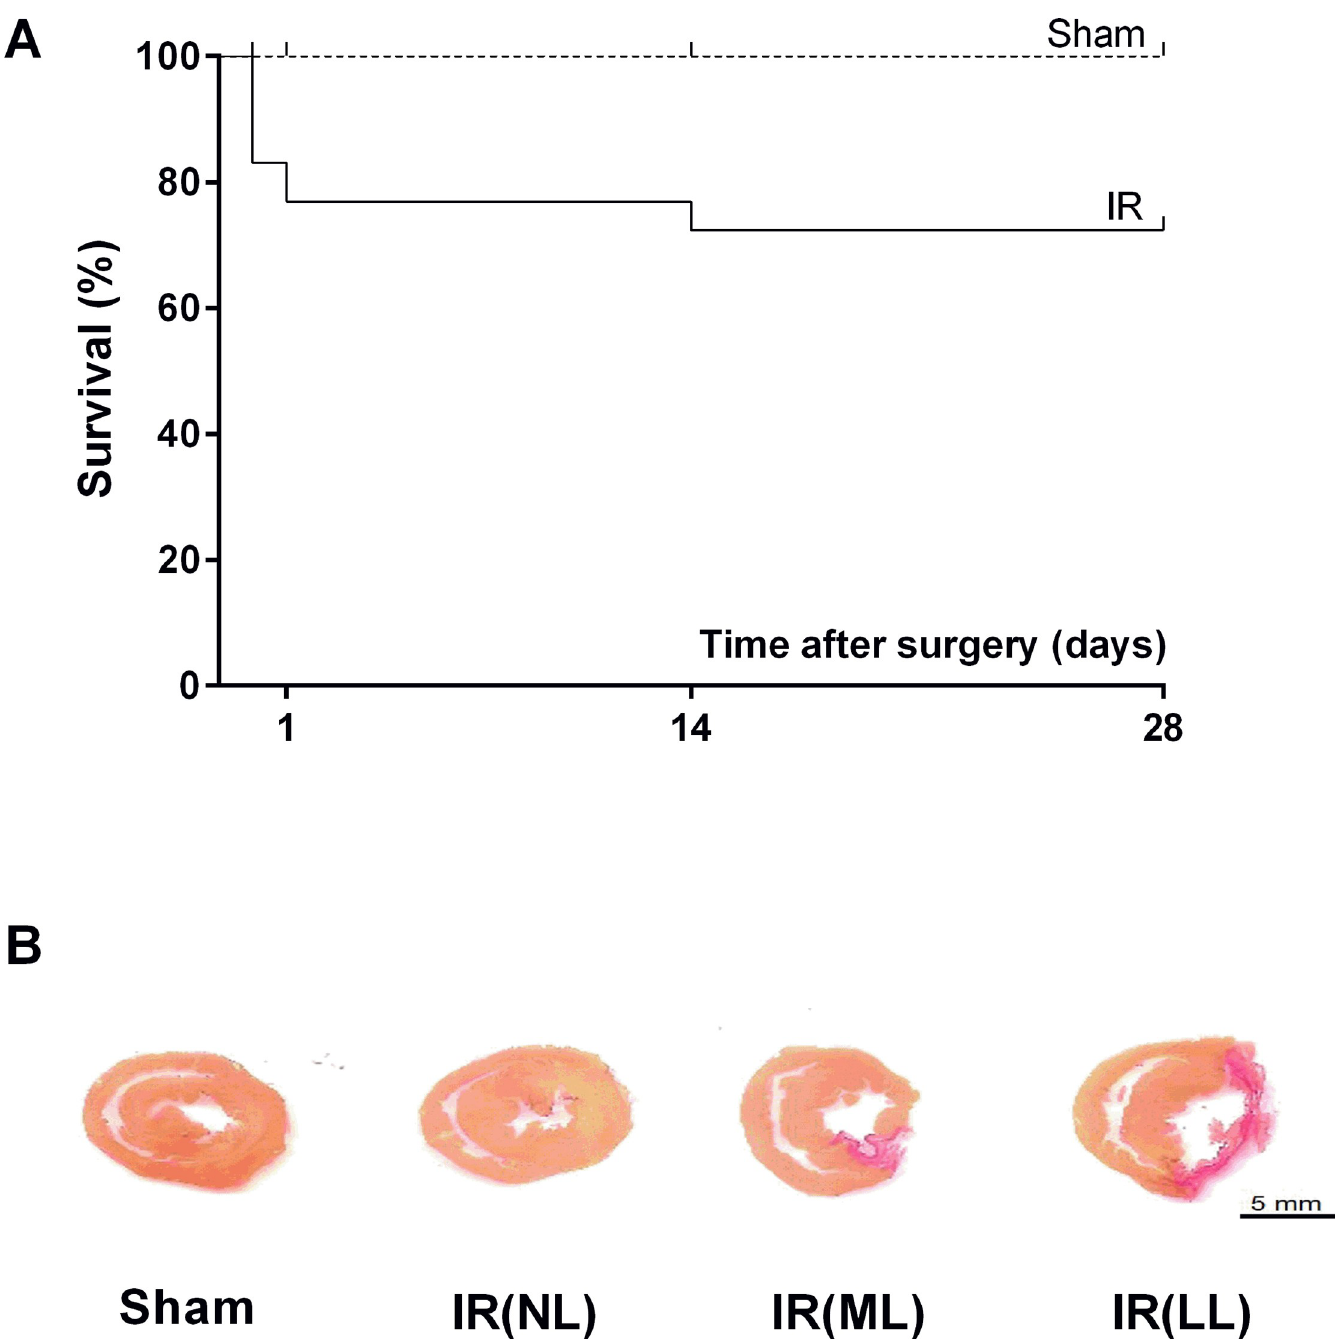
Fig 1. Survival rate and infarct scars in myocardial cross-sections. (A) Survival rate (Kaplan-Meier) from rats, following 4 weeks after sham-operation (Sham) or acute myocardial ischemia-reperfusion (IR). (B) Midventricular cross sections of the heart stained with picrosirius red . The animals were classified according to the presence and size of infarct scars. IR(NL): without a scar; IR(ML): mild infarct scars, i.e. less than 40% of the total circumference of the left ventricle; IR(LL): large infarct scars, i.e. more than 40% of the total circumference of the left